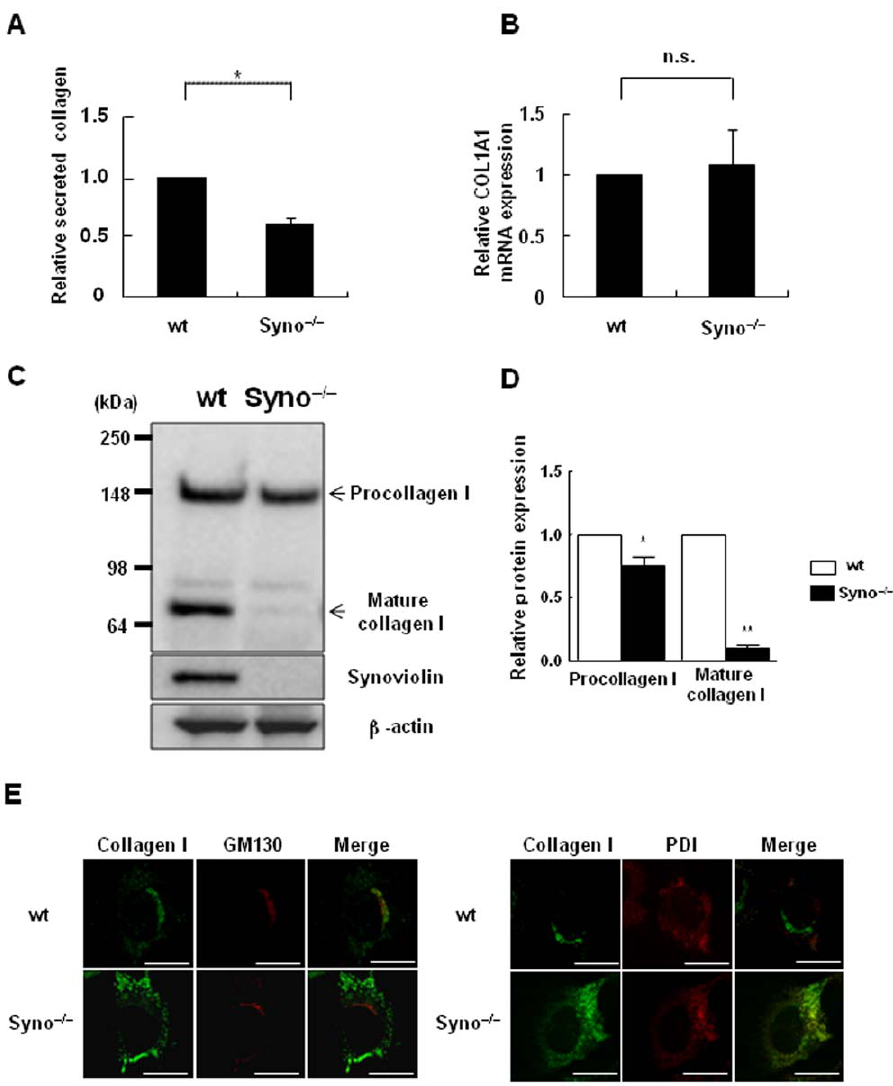
Figure 5. Involvement of synoviolin in collagen synthesis in the maturation of collagen I. (A) Amount of soluble secreted collagen in culture supernatants of wt and Syno 2 / 2 MEFs as quantified by the sircol collagen assay method. The amount of collagen was expressed as a ratio by normalization to the protein concentration in each sample. Data are represented as mean 6 SD (n=3 per group). Unpaired Student’s t -test was used to evaluate statistical significance. * P , 0.01. Immunoblotting analysis of whole-cell lysates of wt and Syno 2 / 2 MEFs by using anti-synoviolin antibody. (B) Effect of synoviolin on COL1A1 mRNA expression in wt and Syno 2 / 2 MEFs. The expression level of COL1A1 mRNA was quantified by real-time RT- PCR. The mRNA level was normalized relative to the amount of the transcript of b -actin, a housekeeping gene. Data are represented as mean 6 SD (n=4 per group). Unpaired Student’s t -test was used for statistical analysis. n.s. = not significant. (C) Effect of synoviolin on the expression of intracellular collagen I. The amount of intracellular collagen I in wt and Syno 2 / 2 MEFs was analyzed by immunoblot analysis using anti-collagen I, synoviolin, and b -actin antibodies. The results were derived from 5 independent experiments. (D) The amount of procollagen I and mature collagen I in wt and Syno 2 / 2 MEFs semiquantified by NIH Image software. Data are represented as mean 6 SEM (n=5 per group). Unpaired Student’s t -test was used for statistical analysis. * P , 0.05, ** P , 0.001. (E) Double immunofluorescence staining was performed using antibodies against type I collagen (AB765P) and GM130 (a marker of cis -Golgi compartment) or protein disulfide isomerase (PDI; a marker of ER). The results were derived from 3 independent experiments. Scale bar =20 m m. doi:10.1371/journal.pone.0013590.g005 TUNEL (green) and a -SMA (red) were analyzed using an in situ apoptosis assay kit and a -SMA antibodies in positive (right panels) and negative controls (left panels) using rat mammary tissue sections. The nuclei were counterstained with DAPI (Vectashield). Scale bar = 200 m m. Found at: doi:10.1371/journal.pone.0013590.s001 (2.23 MB TIF) Figure S1 Double-labeled fluorescent immunohistochemical Figure S2 HE staining of liver tissue and serum biochemical analysis of rat mammary tissue sections as positive and negative tests for wt and Syno + / 2 mice in natural conditions. (A) HE controls for TUNEL staining. The expression and localization of